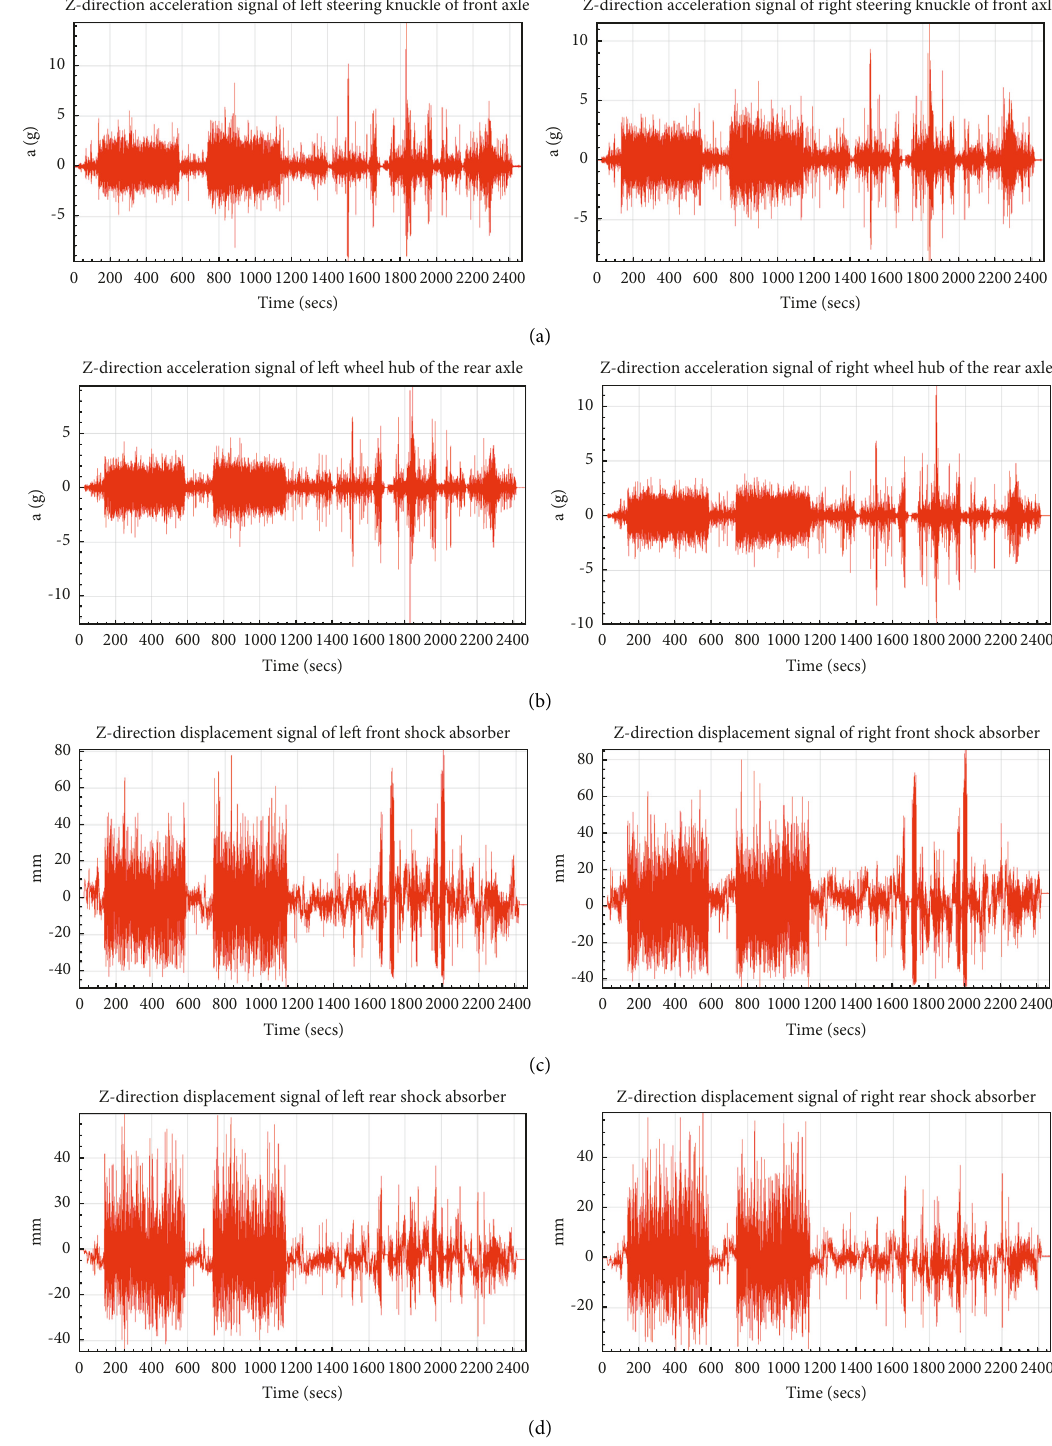
Figure 7: Measured road spectra. (a) Z -direction acceleration signals of the steering knuckle on both sides of the front axle. (b) Z -direction acceleration signals of wheel hubs on both sides of the rear axle. (c) Z -direction displacement signals of left and right front shock absorbers. (d) Z -direction displacement signals of left and right rear shock